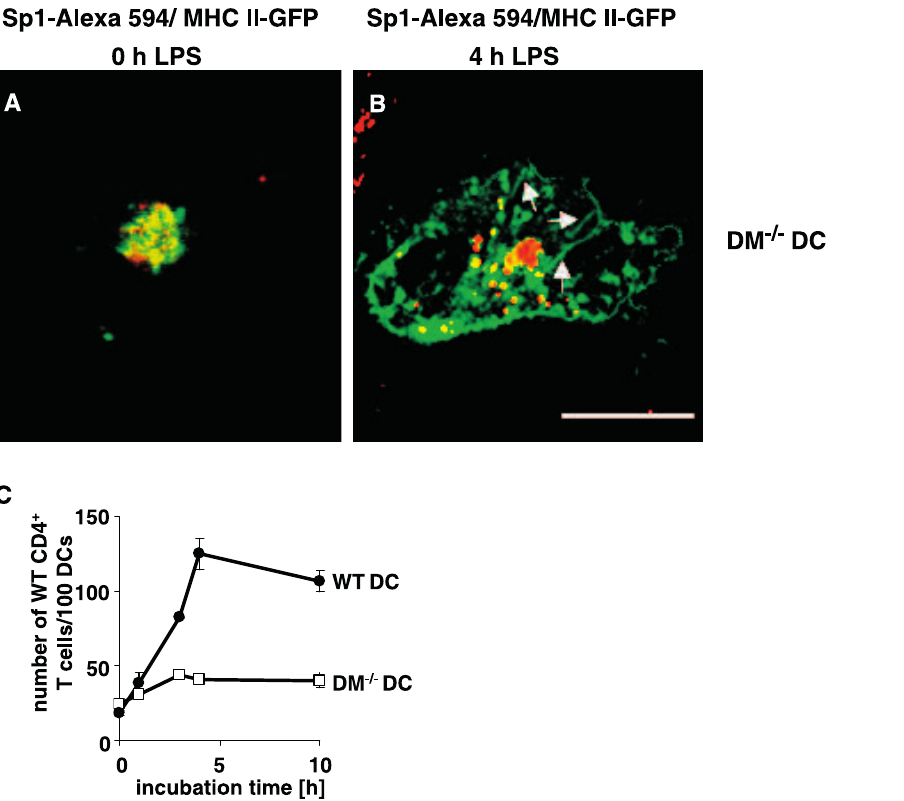
Figure 7. DM Dependency of Sp1 Retrograde Transport in MHCII-Positive Tubules (A) DM (cid:3) / (cid:3) iDCs transfected with MHCII-GFP were treated for 30 min with Sp1-Alexa 594 (500 l g/ml) before live cell imaging by confocal microscopy. Merged fluorescence images of DM (cid:3) / (cid:3) iDCs reveal co-localization of Sp1 with MHCII-GFP in lysosomes. No MHCII is found on the cell surface. (B) DM (cid:3) / (cid:3) iDCs transfected with MHCII-GFP were pre-incubated with Sp1-Alexa 594 (500 l g/ml) for 30 min and then treated with LPS for 4 h. Merged fluorescence live cell images of confocal microscopy demonstrate that DCs form MHCII-GFP–positive tubules by 4 h of stimulation with LPS that extend from the perinuclear area to the cell surface (arrows) while Sp1-Alexa 594 remains lysosomal (right panel). Scale bar, 10 l m. (C) DCs from WT or DM (cid:3) / (cid:3) mice expressing MHCII-GFP were stimulated with Sp1-Alexa 594 (500 l g/ml) for 30 min and LPS for various time intervals. Immune interactions with CFSE-labeled WT T cells were analyzed by live cell fluorescent microscopy imaging (see also Figure 2E and 2F).